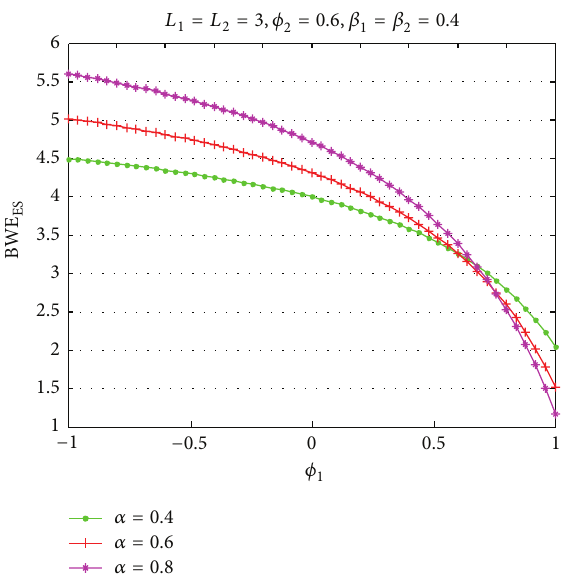
Figure 8: Impact of 𝛼 on bullwhip effect for different 𝑘 under the MA.